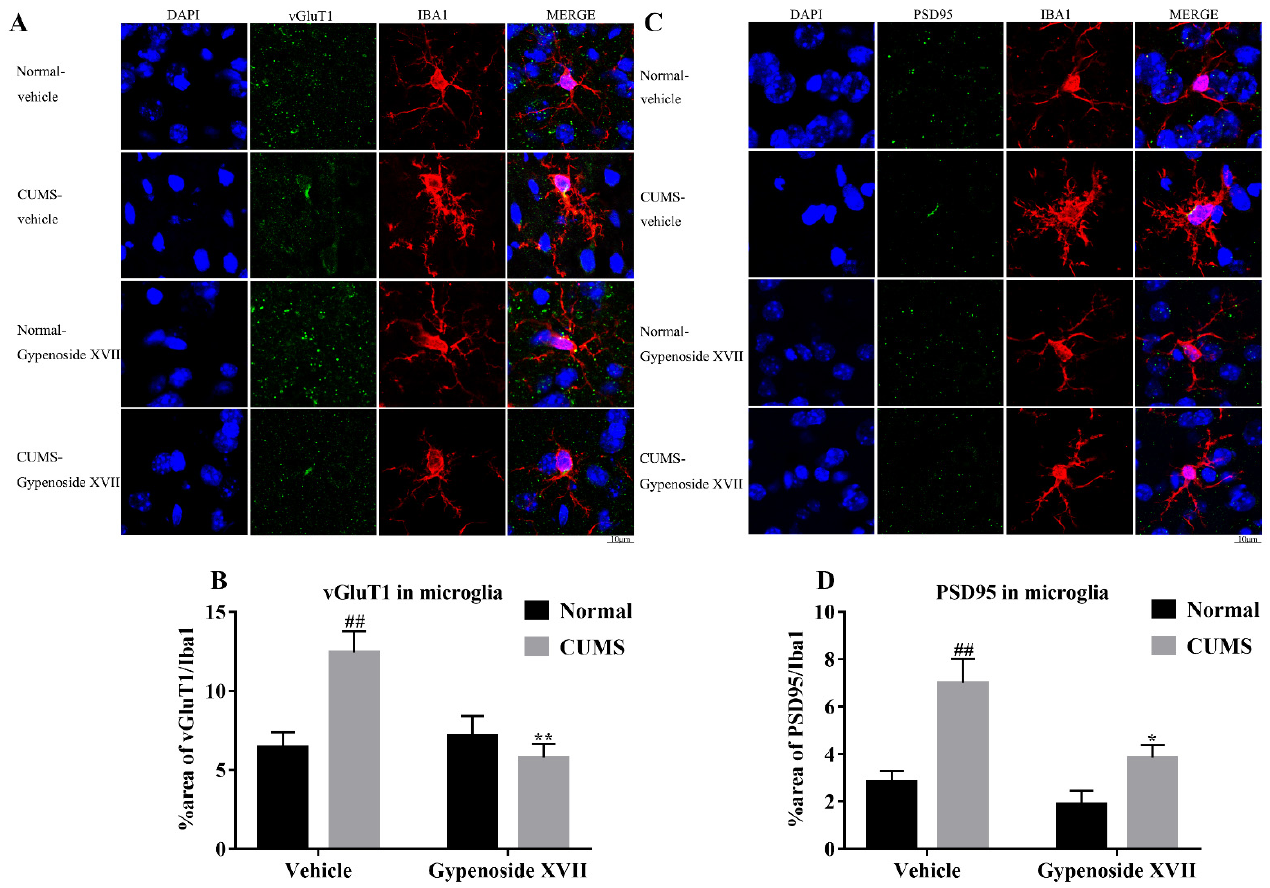
Figure 5. Gypenoside XVII prevented synaptic pruning in the prefrontal cortex ( n = 4). Presynaptic protein vGluT1 in microglia ( A , B ). Postsynaptic protein PSD95 in microglia ( C , D ). ## p < 0.01 versus the Normal-vehicle group. * p < 0.05 and ** p < 0.01versus the CUMS-vehicle group.